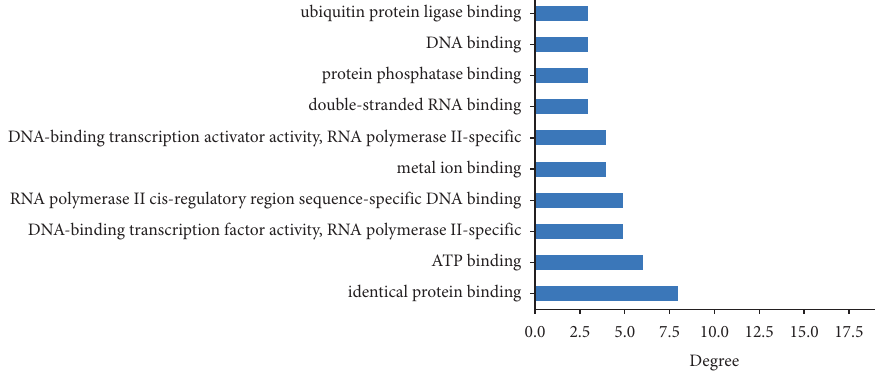
Figure 5: The highest degree of molecular function with important protein.